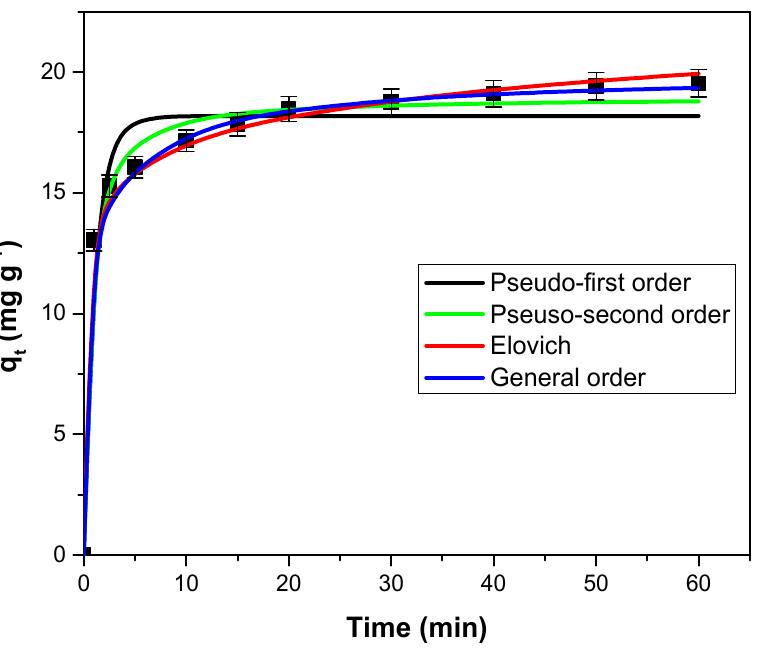
Figure 6. The experimental data and the fitted kinetic models curves for crystal violet adsorption on adsorbents obtained from motherwort biomass. Table 3. The tested kinetic models’ constants and the corresponding statistical parameters.